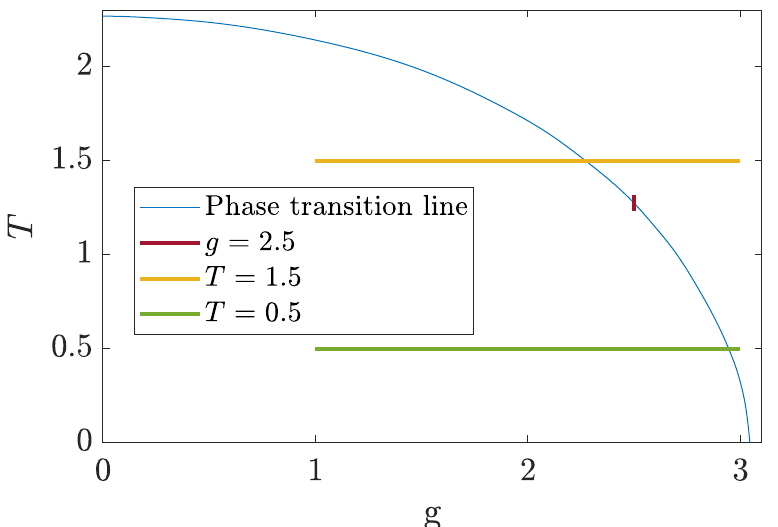
Figure 5: The phase diagram of the 2- transverse-field Ising model: the ordered fer- romagnetic phase is separated from the disordered paramagnetic phase by a second- order phase transition. We show the lines of constant T = 2.5, g = 0.5 and g = 1.5 that are used in Figs. 6 and 7. The data for the transition line is taken from the Monte-Carlo data in Ref. [ 23 ]